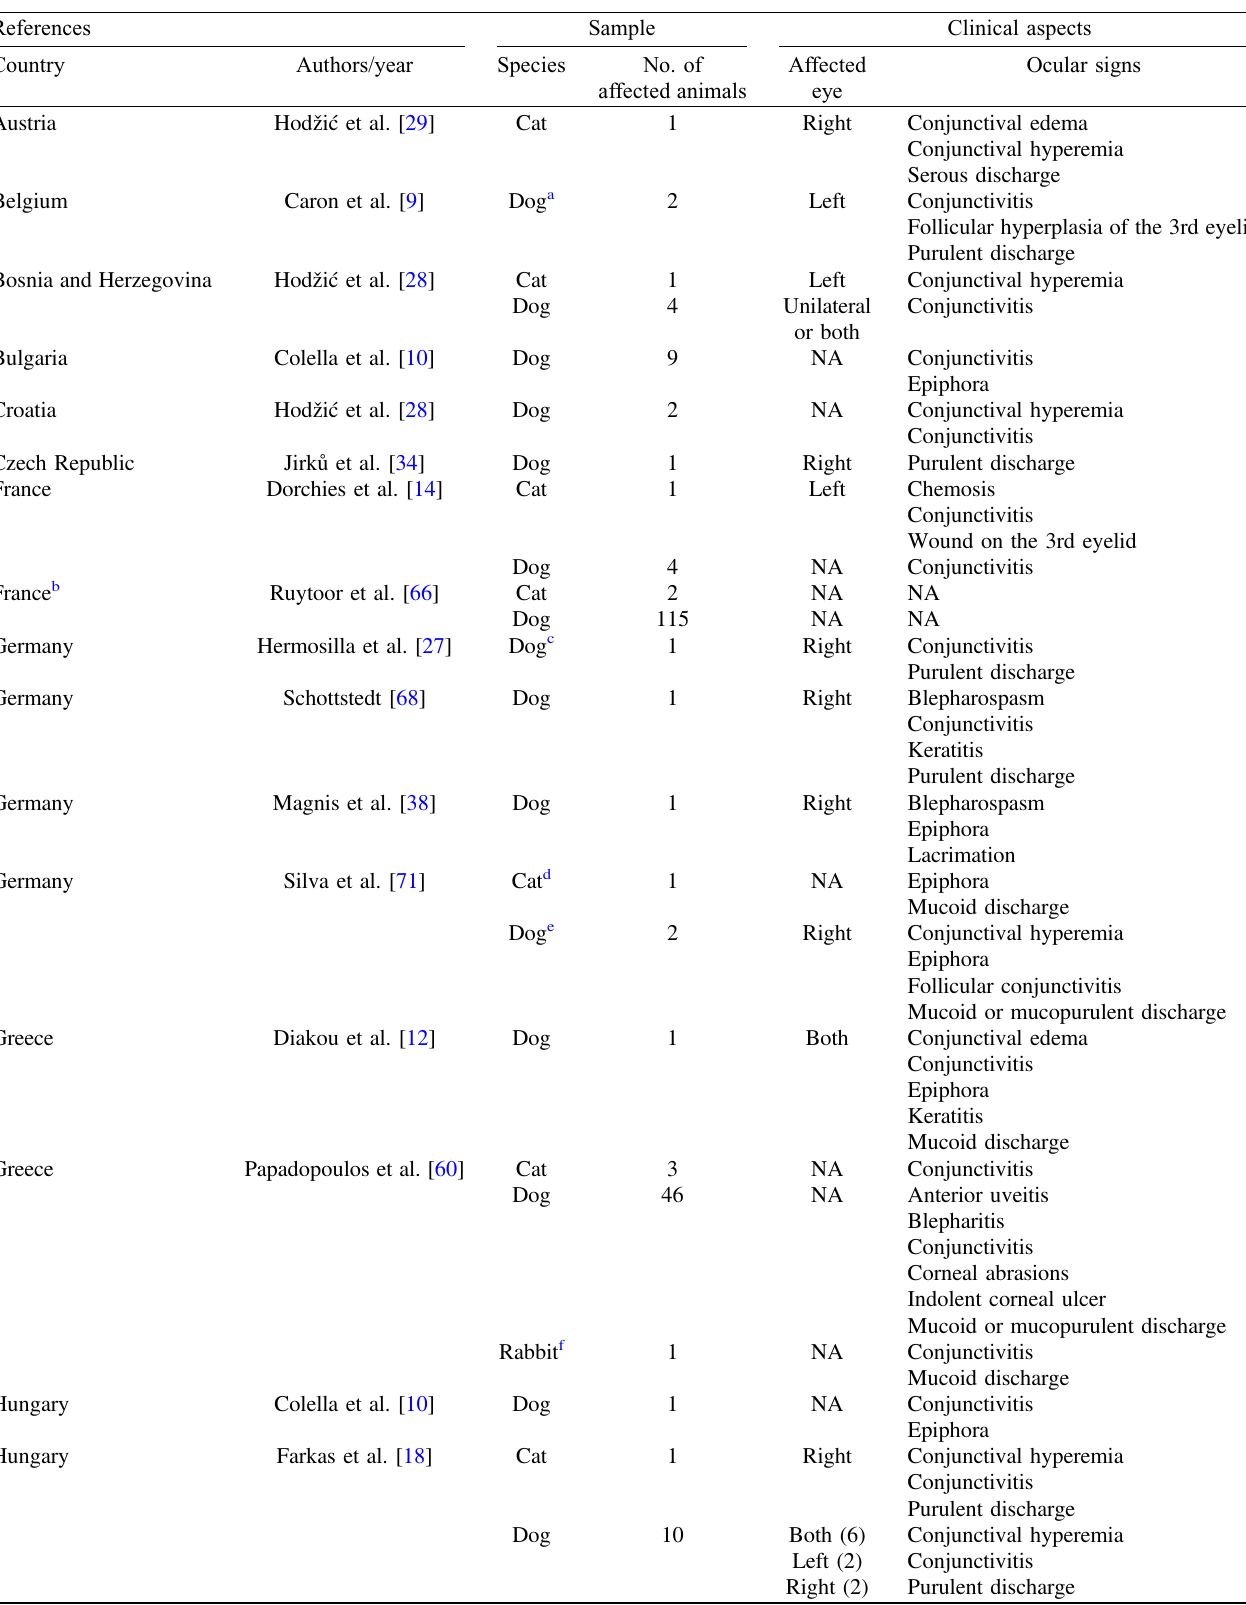
Table 1. Features of the studies included in the qualitative analysis regarding T . callipaeda infection in companion animals in